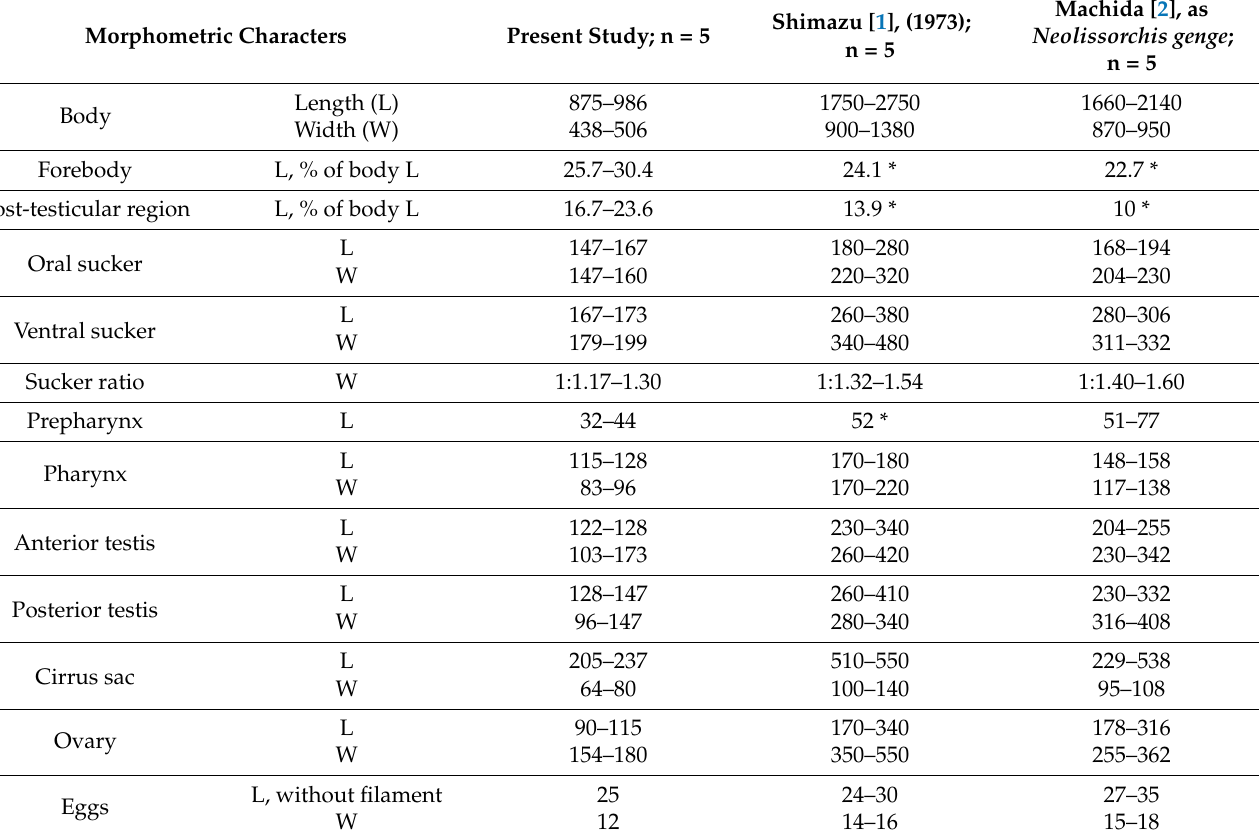
Table 2. Measurements ( µ m) of Anarhichotrema ochotense from present and previous studies: n—number of specimens measured, *—estimated from the published